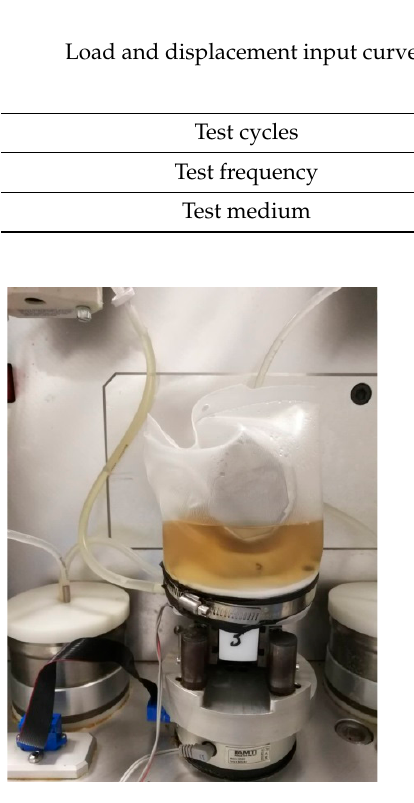
Figure 2. Setup of knee prosthesis for the wear test. The gravimetric wear and wear rate were calculated according to ISO 14243-2